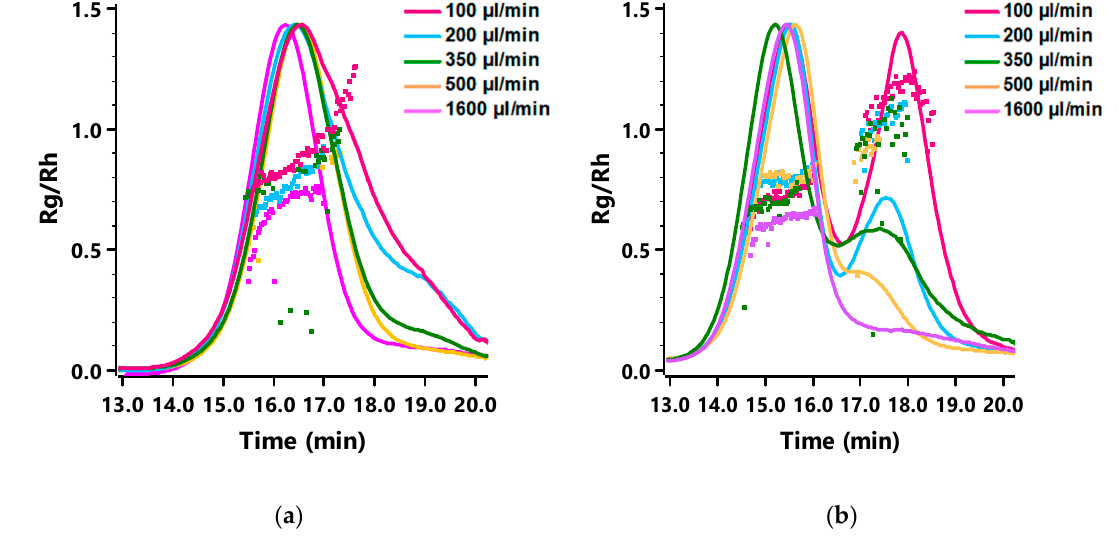
Figure 5. Fractograms of nanoparticles obtained at varying microfluidic flow rates measured with AF4-MALLS. ( a ) Block copolymer A (mPEG 5K - b -p(HPMA-Bz) 17.1K ) at concentration of 5 mg/mL. ( b ) Block copolymer D (mPEG 5K - b -p(HPMA-Bz) 2.7K ) with a concentration of 5 mg/mL.